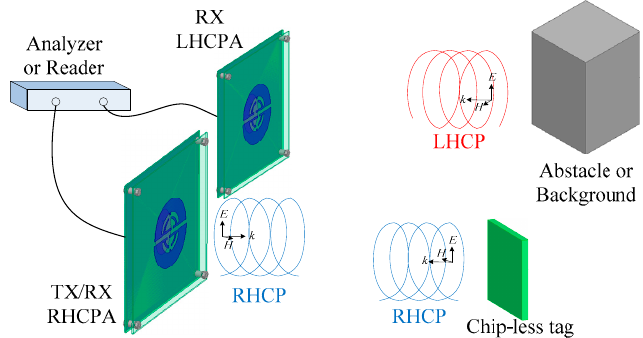
Figure 1. Principle of operation of the target detection based on chip-less tag technology.